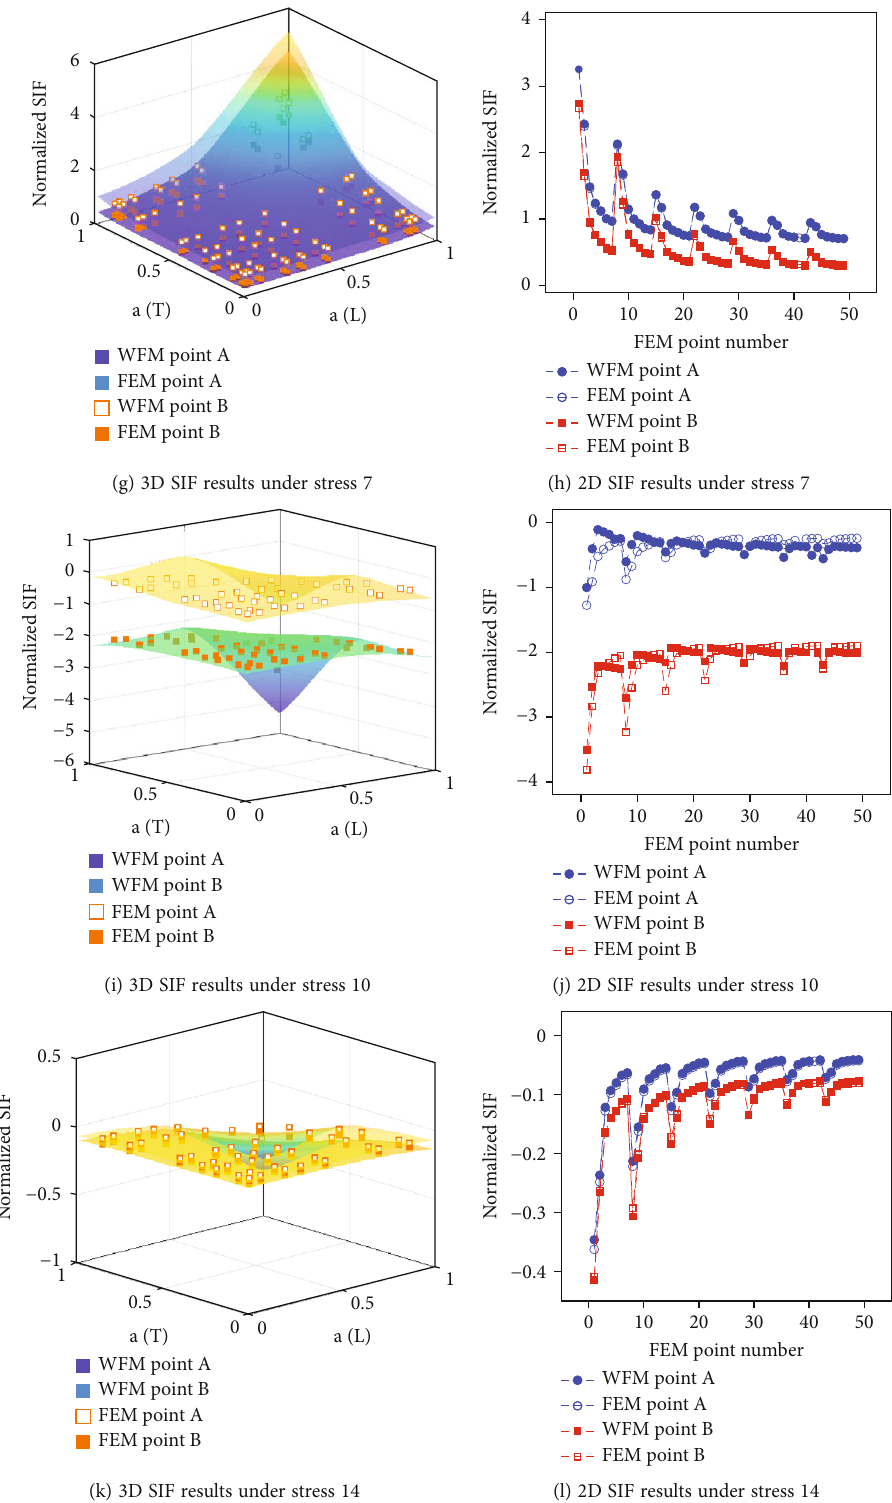
Figure 7: Comparison of SIFs on corner cracks for point A and point B with di ff erent stress